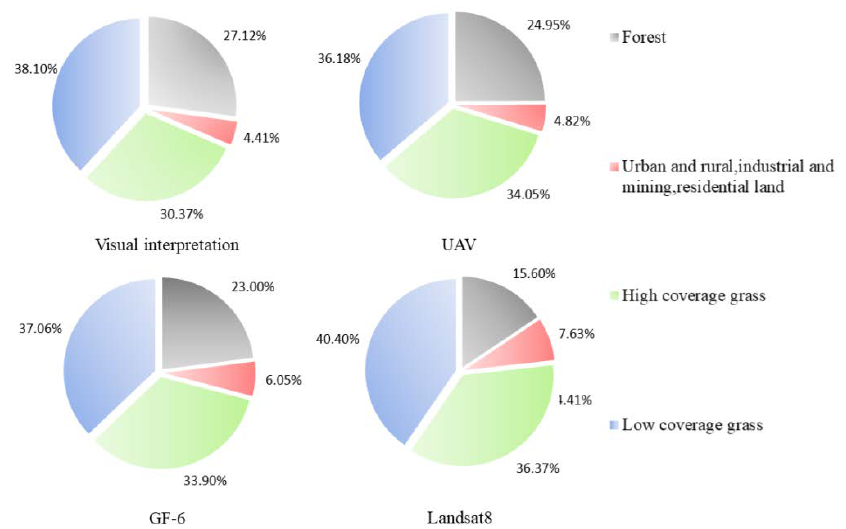
Figure 11. Proportion of landslides under different surface coverage in remote sensing images.